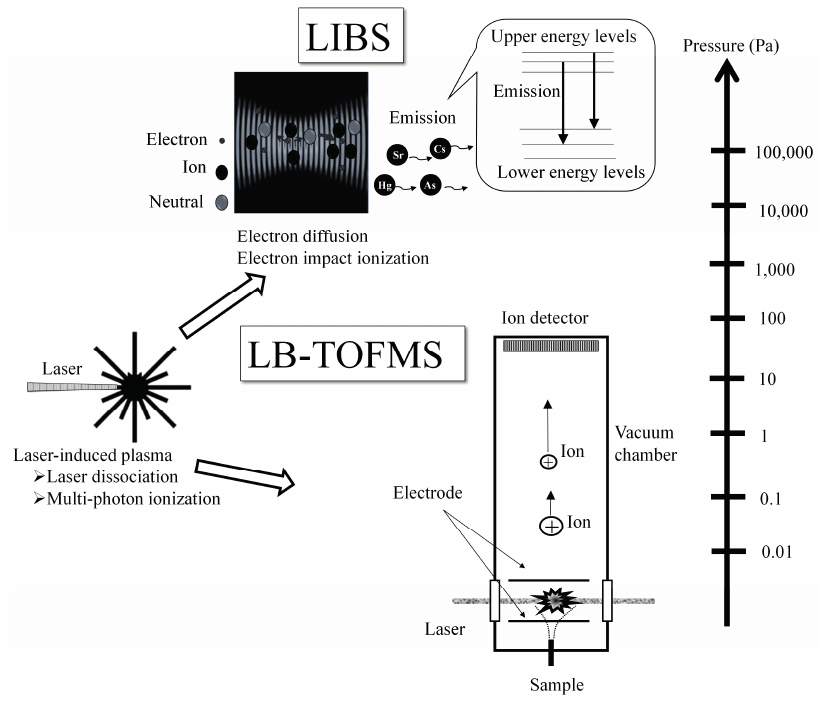
Figure 1. Different plasma generation processes and detection features of laser-induced breakdown spectroscopy (LIBS) and laser breakdown time-of-flight mass spectrometry